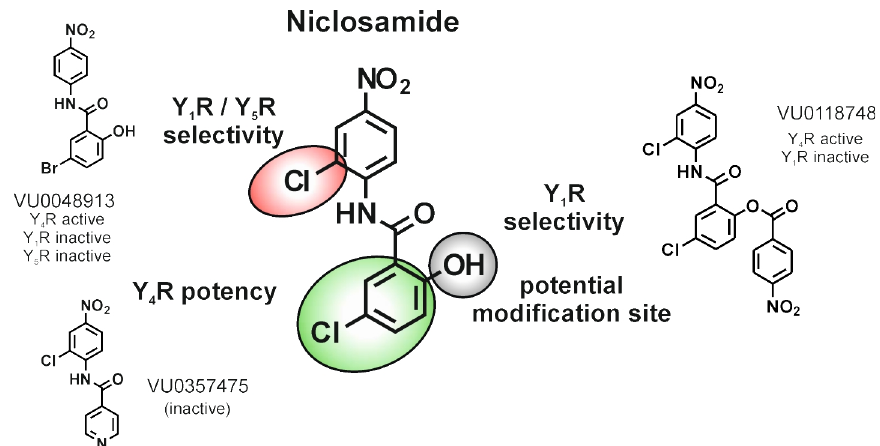
Fig 5. Distinct positions of the Niclosamide scaffold were shown to be relevant for Y 4 R PAM activity and YR selectivity. Substitutions in the benzoyl ring are important for Y 4 R potency (green), and offer a potential modification site (grey). Modifications in the aniline ring engender selectivity towards Y 1 R / Y 5 R subtype